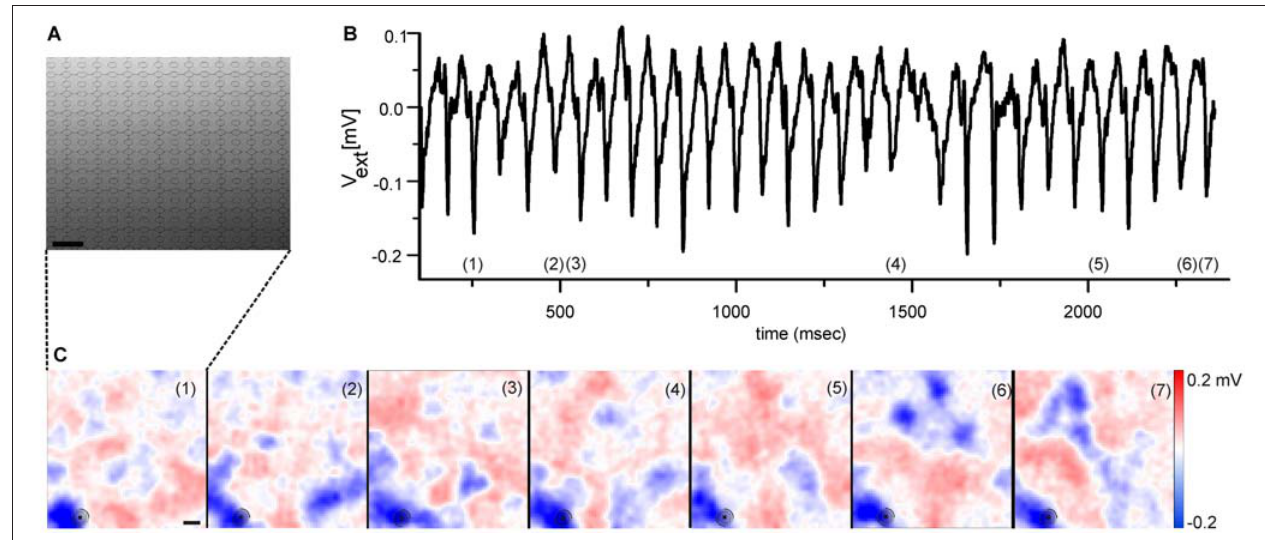
FIGURE 1 | Electrical imaging the rhythmic local field potentials (LFPs) in the ganglion cell layer (GCL) using high-density microelectrode arrays. (A) Raster electron micrograph displaying part of a high-density microelectrode array. Round structures represent the recording electrodes. Scale bar: 32 µ m. Figure modified from Bertotti et al. (2014). (B) Extracellular voltage trace recorded by one selected electrode [marked with circle in the lower left corner of each image in (C) ] reveals the rhythmically occurring LFP. The voltage trace has been low-pass filtered ( < 100 Hz). (C) Selected color coded images of the extracellular voltage recorded by a high-density microelectrode array as shown in (A) . The numbers in each image correspond to numbers in (B) , which identify the time of maximal LFP amplitude. The periodically occurring LFPs share a high spatial similarity. Scale bar: 100 µ m. (B,C) modified from Menzler and Zeck (2011).